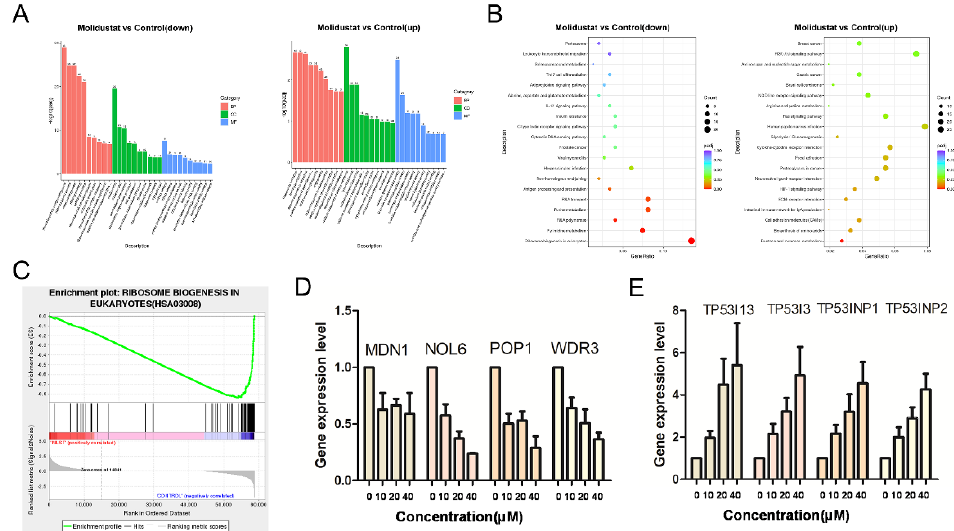
Figure 8. Possible mechanism of molidustat-induced apoptosis in MEC-1 cells. ( A ) MEC-1 cells were treated with 0 or 20 μM molidustat, and their RNA was extracted and sequenced. GO analysis was performed on the upregulated and downregulated differentially expressed genes of the MEC-1 cells in the experimental (20 μM) and control groups (0 μM). The histogram of enriched pathways is shown. ( B ) KEGG analysis was performed on the upregulated and downregulated differentially expressed genes, and the dot plot of KEGG enriched pathways is shown. ( C ) Gene Set Enrichment Analysis (GSEA) results of KEGG enrichment analysis of ribosome biogenesis showing that the ma- jority of genes in the ribosome biogenesis pathway was downregulated after 20 μM molidustat treatment (most vertical lines distributed to the right of the horizontal axis). ( D , E ) MEC-1 cells were treated with 0, 10, 20, or 40 μM molidustat, and the expre ssion of differential expressed genes was verified using qPCR.